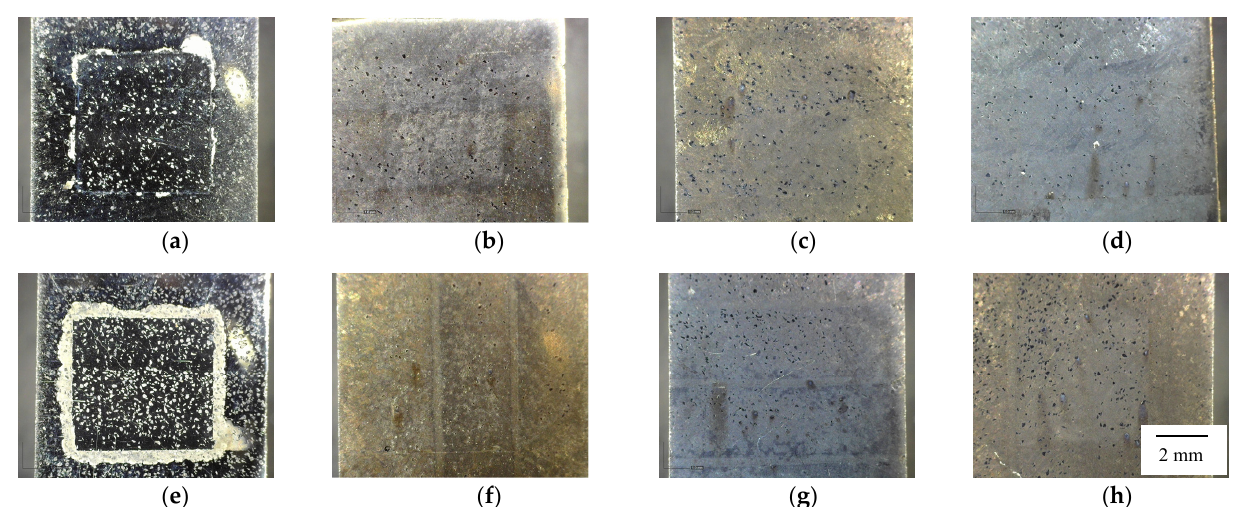
Figure 10. Surface morphologies after anodic polarization measurements of the as-deposited and nitrided layers with various WC compositions and nitriding temperatures: ( a ) WC 20 wt.% with as-deposited, ( b ) WC 20 wt.% at 400 °C, ( c ) WC 20 wt.% at 425 °C, ( d ) WC 20 wt.% at 450 °C, ( e ) WC 40 wt.% with as-deposited, ( f ) WC 40 wt.% at 400 °C, ( g ) WC 40 wt.% at 425 °C, and ( h ) WC 40 wt.% at 450 °C.